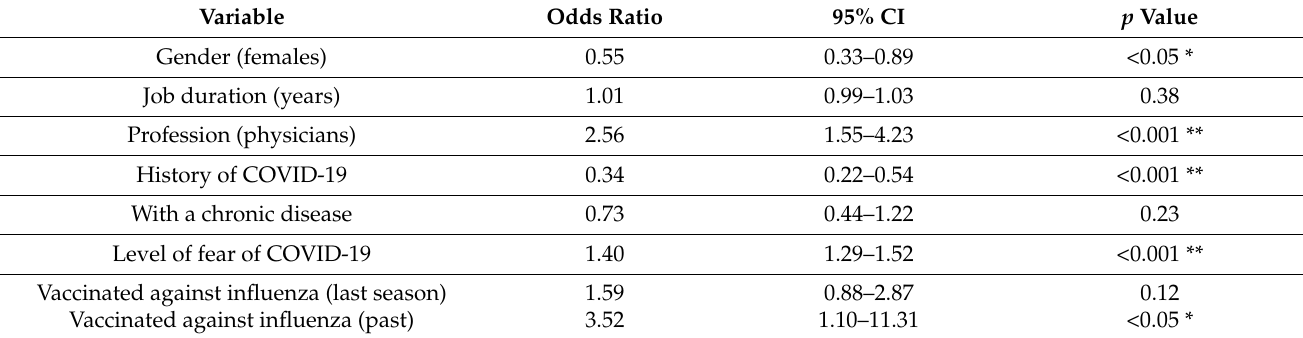
Table 3. Predictors of COVID-19 vaccination (multivariate logistic regression